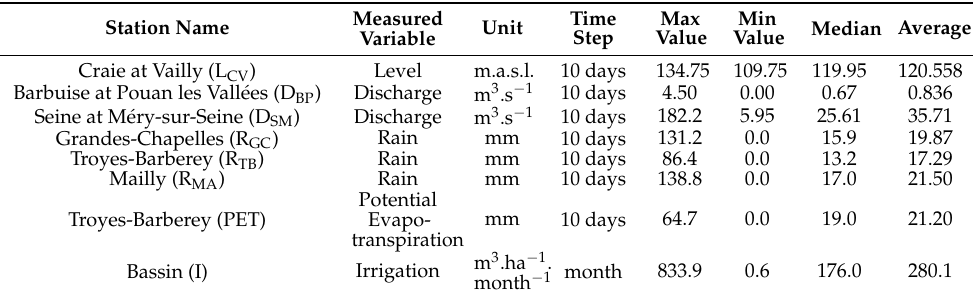
Table 1. Simple statistics on Champagne chalk time series from 1977 to